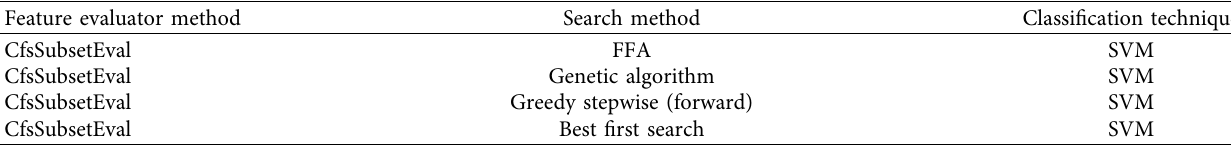
Table 1: Description of the feature selection method and classification technique used for fraud